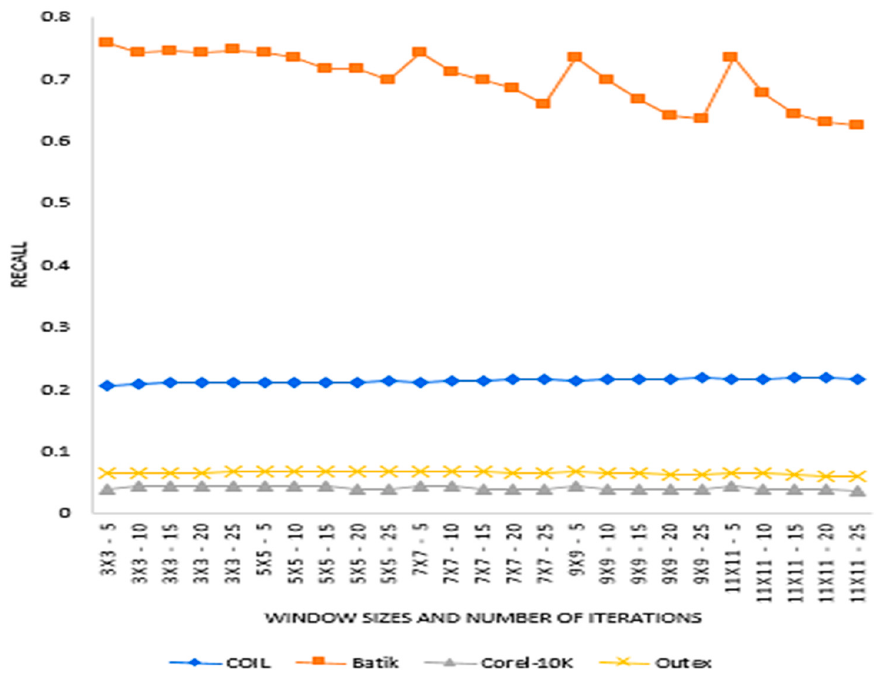
Figure 4. Average recall for various window sizes and the number of transformations for the four datasets.